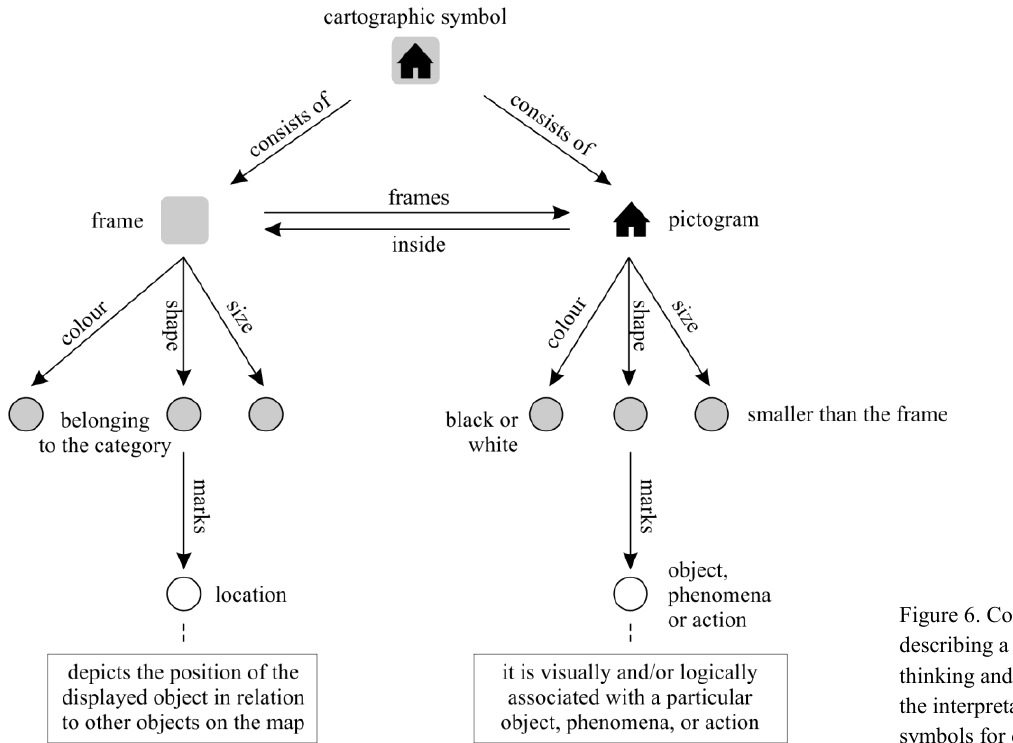
Figure 6. Cognitive scheme describing a recognised pattern of thinking and behaviour of users in the interpretation of cartographic symbols for crisis